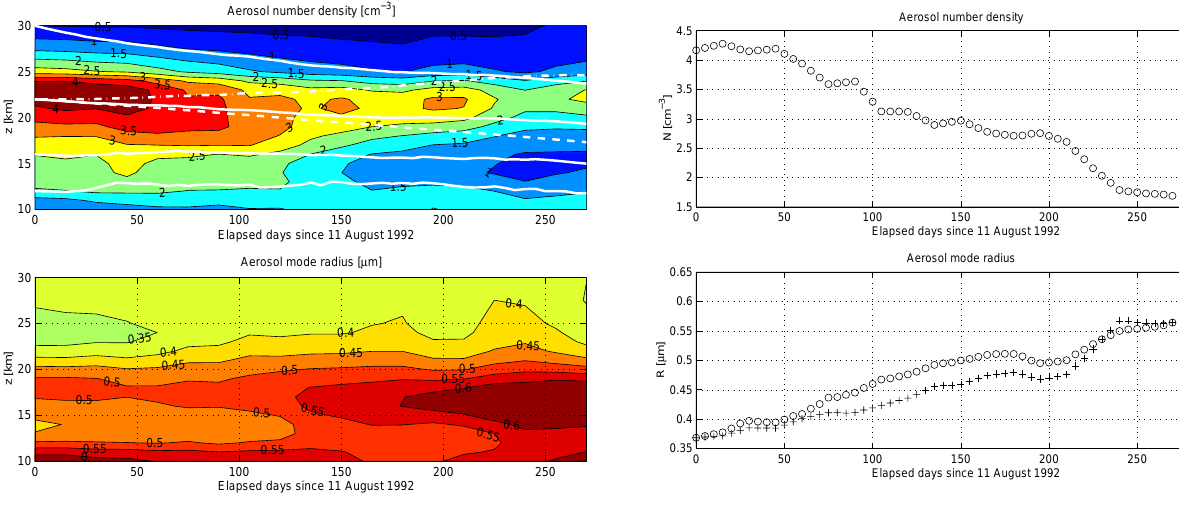
Fig. 5. Top: latitude averaged temporal evolution of N ( t ) . Full lines refer to vertical trajectories starting at z = 12, 16, 22 and 30km, respectively, including transport and sedimentation. The dashed line is the z = 22km with sedimentation only while the dot- dashed line takes only transport into account. Bottom: temporal evolution of mode radius r m .